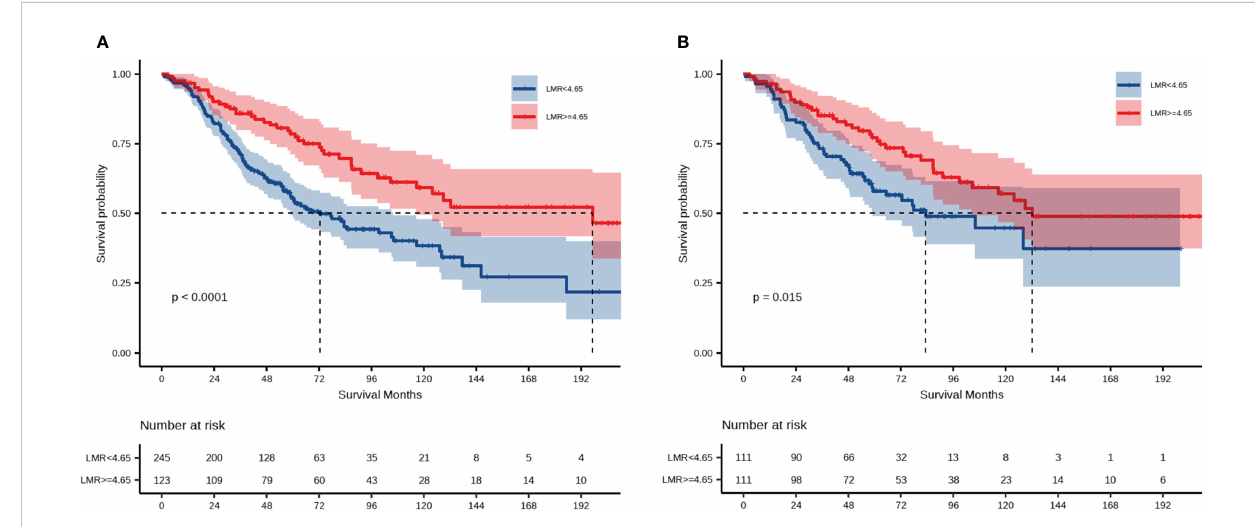
FIGURE 2 Prognostic signi fi cance of LMR for OS. (A) Overall survival among the entire cohort; (B) overall survival among the PSM